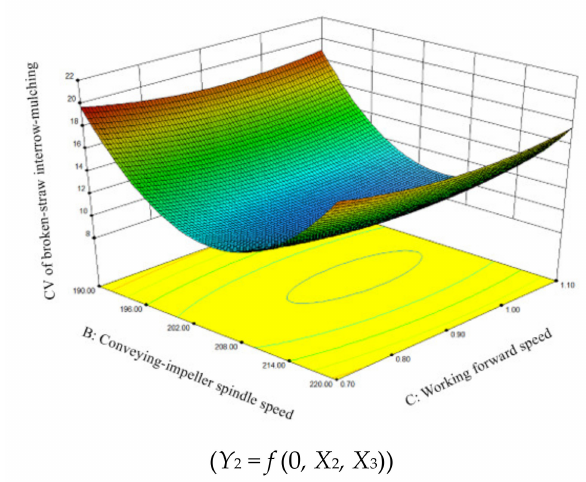
Figure 6. Effect of interaction between factors on straw crushing stability.